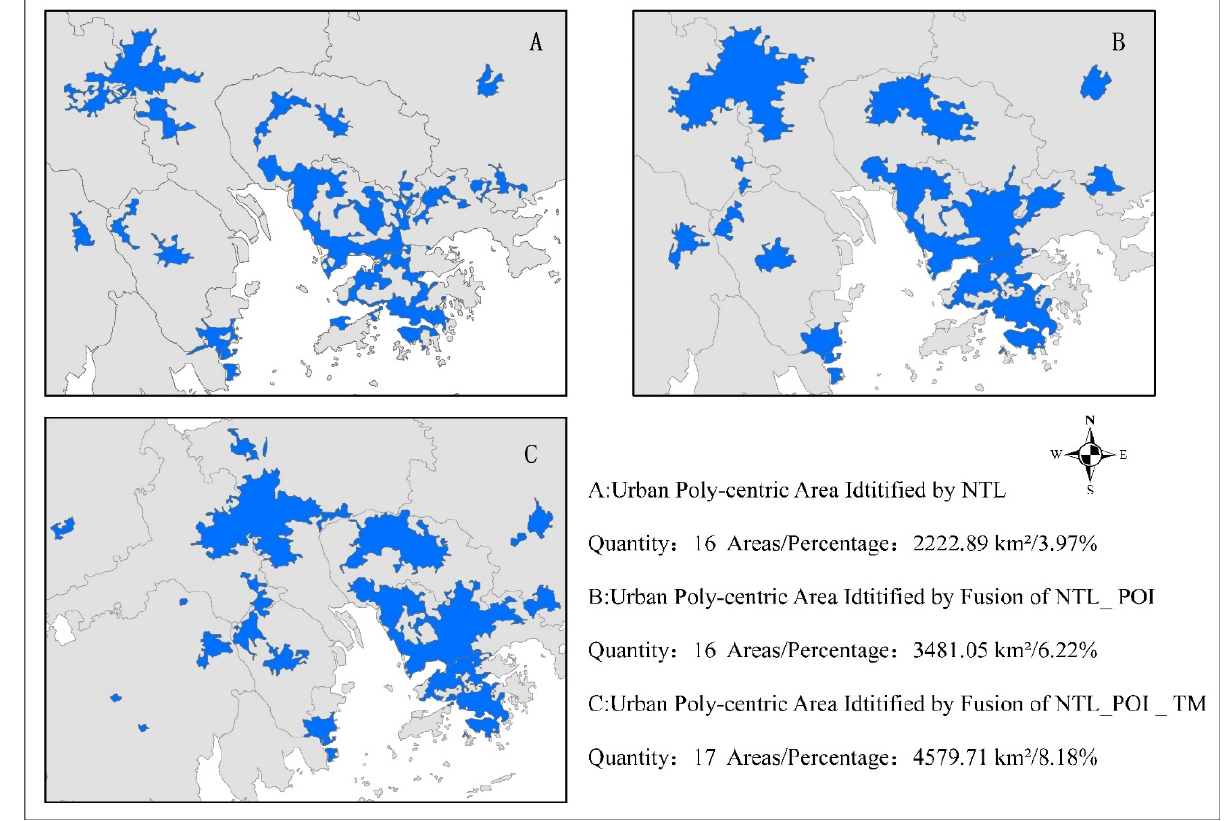
Figure 7. The identification results of polycentric spatial structure in the GBA.